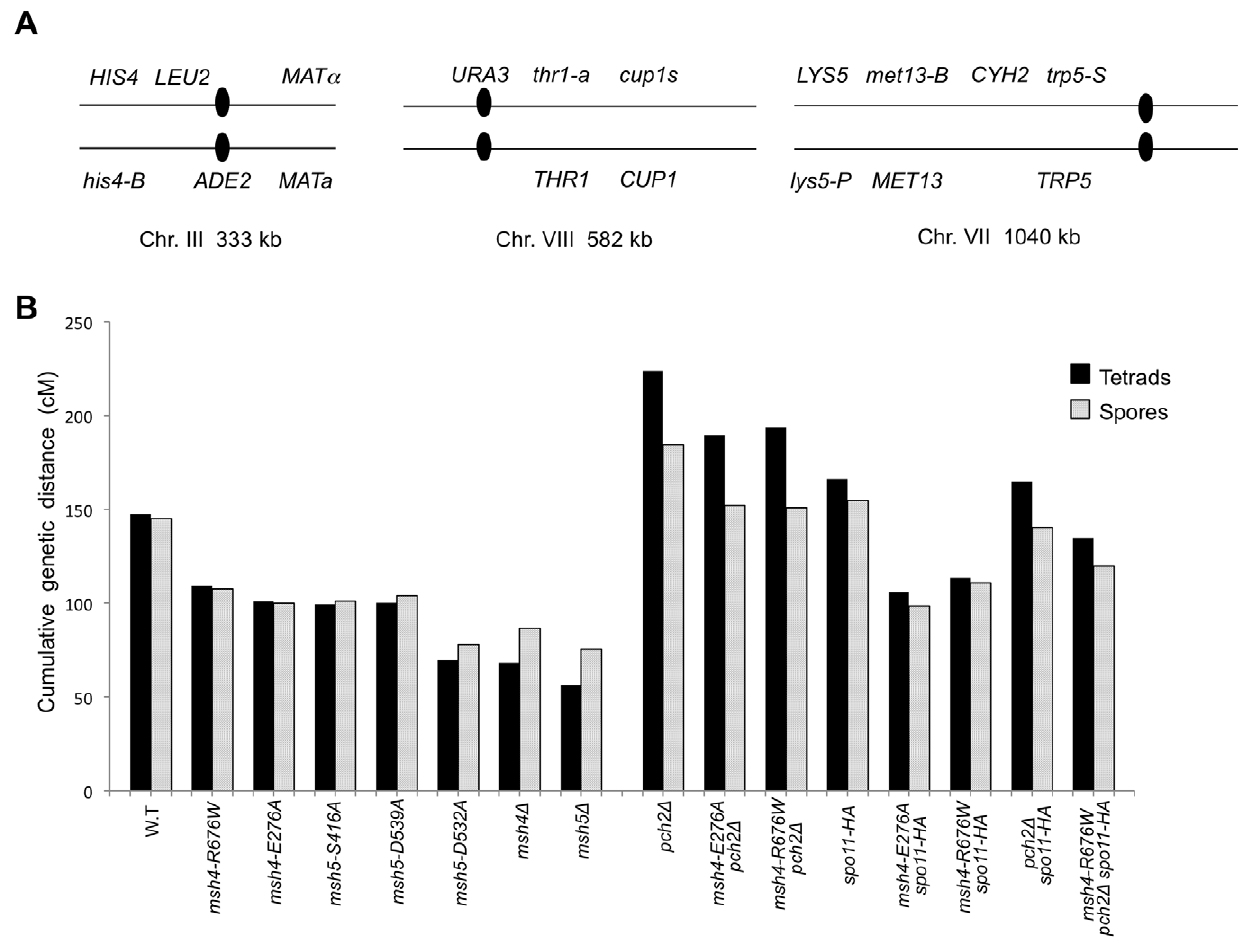
Figure 5. Cumulative genetic map distance in msh4/5 hypomorphs and double and triple mutations with pch2 D and spo11-HA . (A) Location of genetic markers assayed on chromosomes III, VII and VIII in the NHY strain background. Solid circle indicates the centromere. (B) Sum of the genetic map distance (from total spores and complete tetrads) over chromosomes III, VII and VIII in the NHY942/NHY943 strain background. Raw data are shown in Table 2. Data for wild-type, pch2 D , spo11-HA , and pch2 D spo11-HA are from Zanders and Alani [21].